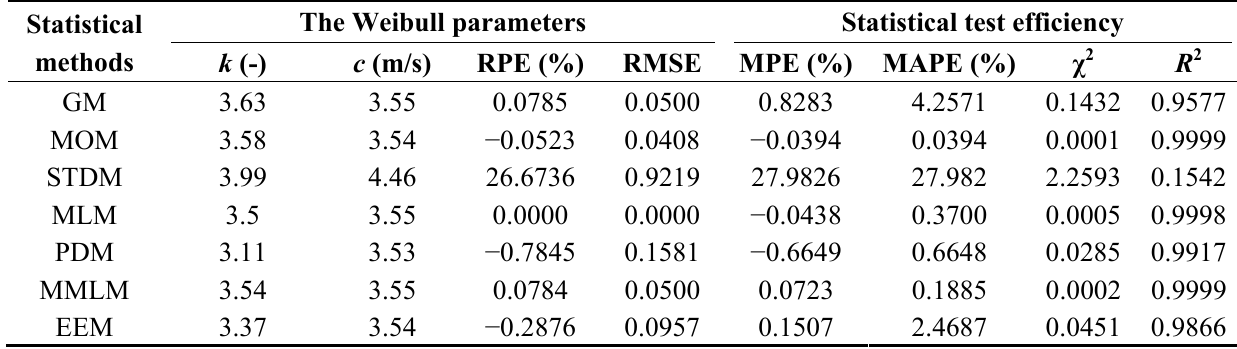
Table 4. The Weibull distribution analysis for Station-I at 20 m height. GM: graphical